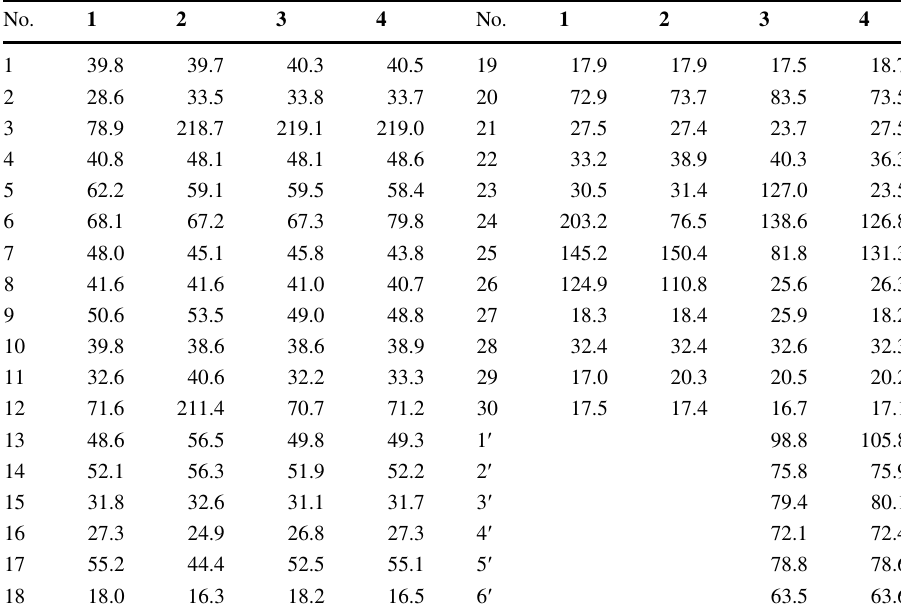
Table 1 13 C (150 MHz) NMR data of 1 – 4 in pyridine- d 5 ( δ in